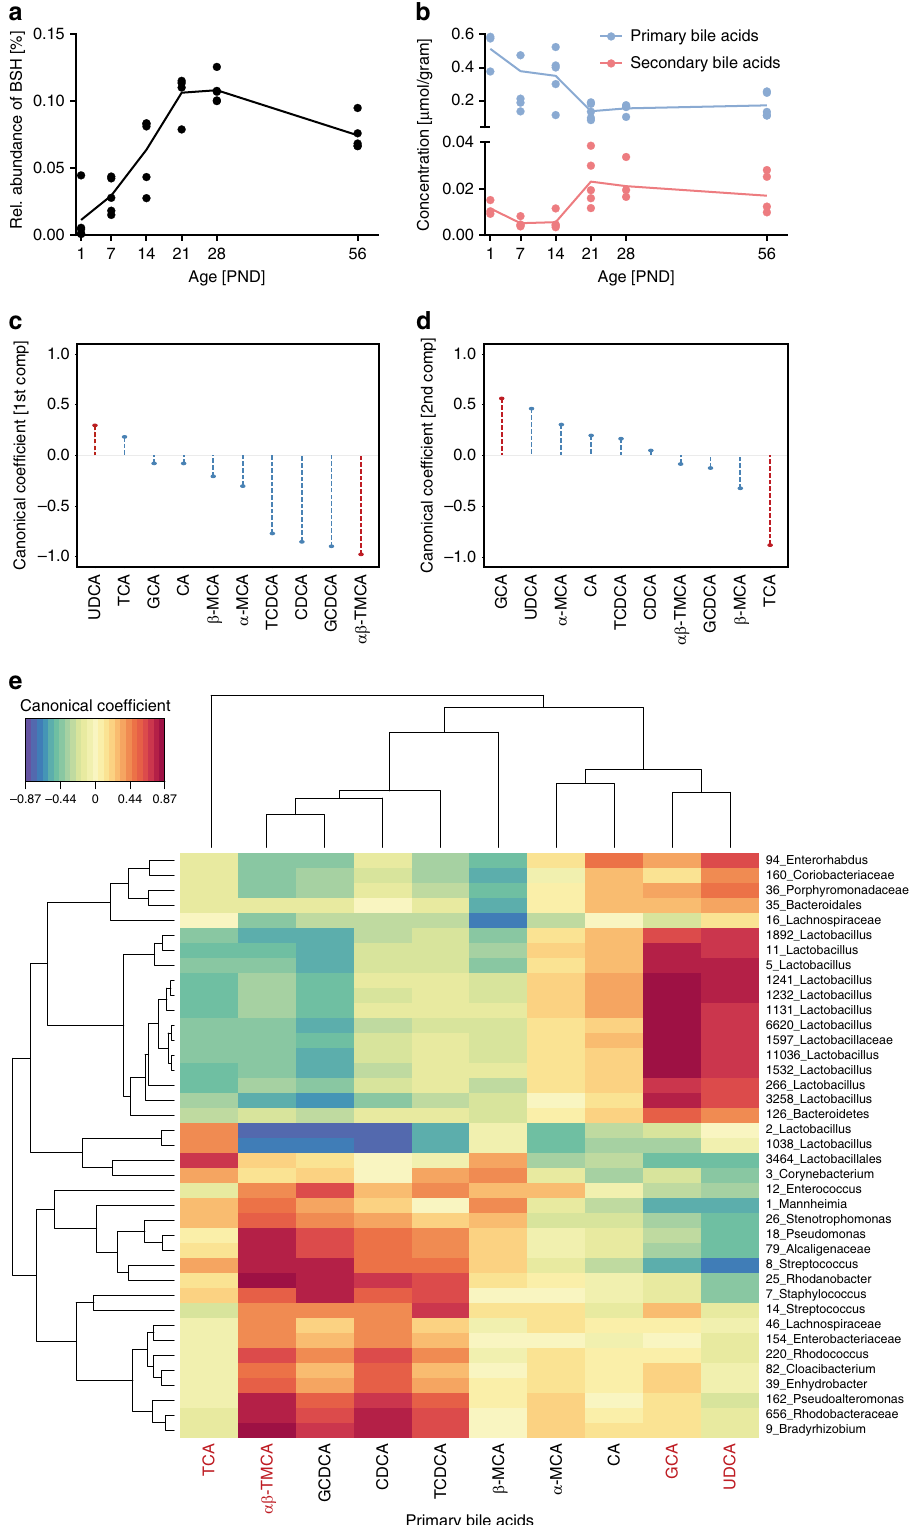
Fig. 3 Enterohepatic cooperation in the maturation of the microbiota. a Relative abundance of the predicted bacterial bile salt hydrolyses (KO1442) in the small intestinal microbiota ( n = 5 per group, means connected and replicates). b Total concentration [ µ mol / gram] of primary (blue) and secondary (red) bile acids ( n = 3 for PND1 and n = 5 for PND7-56, means connected and replicates). c , d Coef fi cients of the regularized canonical correlation analyses (rCCA) indicating the relationship between primary bile acids and small intestinal OTUs on the fi rst component ( c ) and second component ( d ) (selected bile acids are highlighted in red). e Correlation heatmap based on the coef fi cients of the rCCA between hepatic primary bile acid concentrations and relative abundances of small intestinal OTUs indicated a strong positive effect (red) of GCA and UDCA on many Lactobacillus OTUs. Source data are provided as a Source Data fi